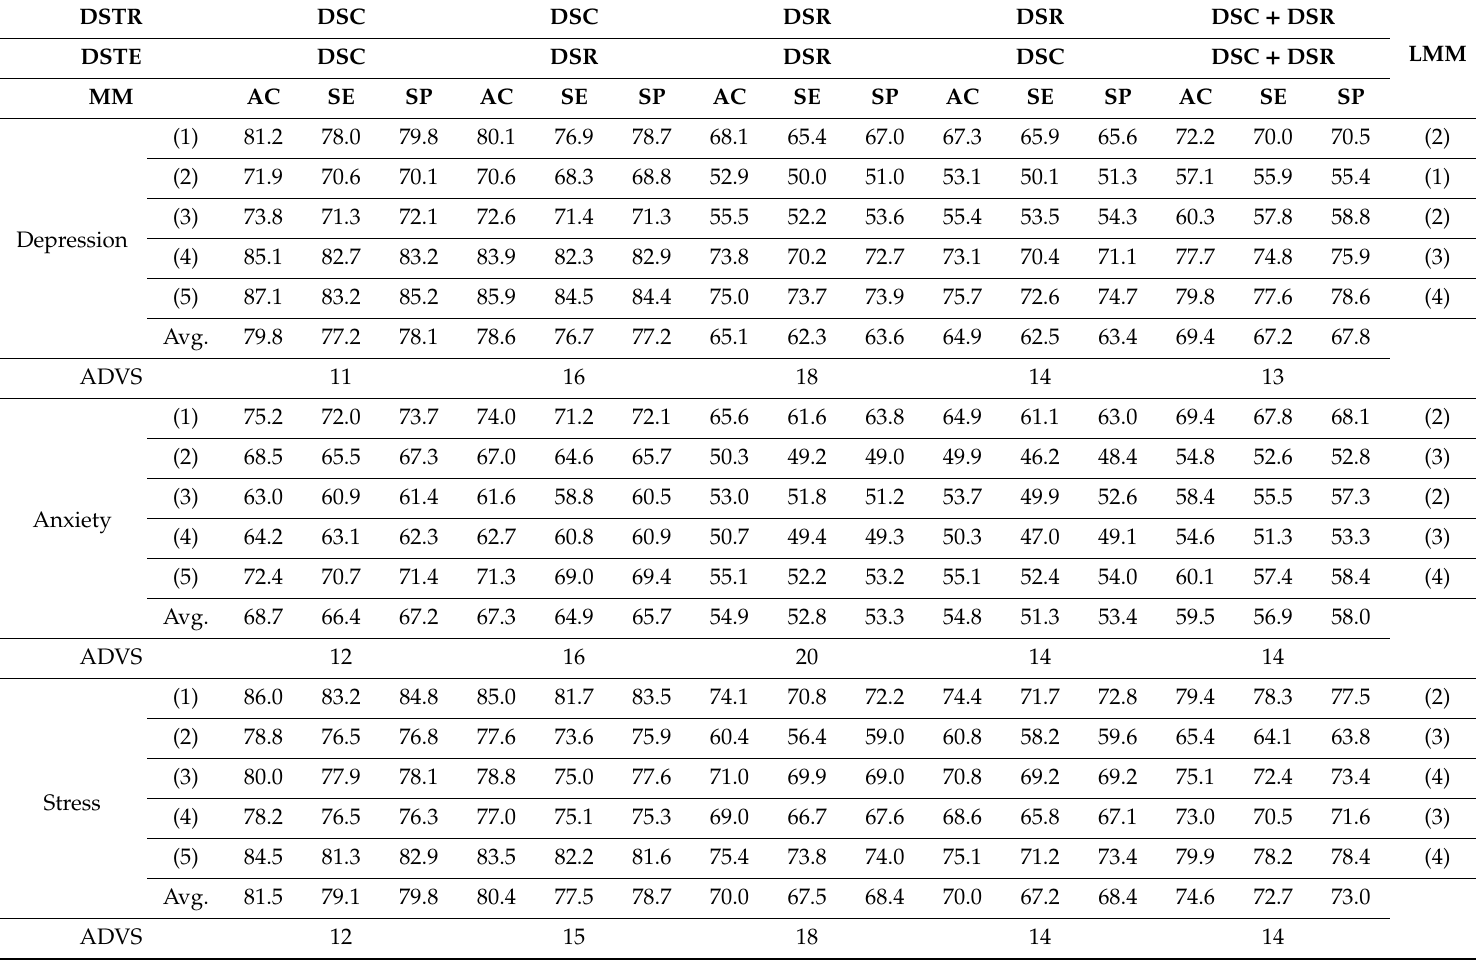
Table 2. DASS levels prediction accuracy, sensitivity, specificity, and average duration of analyzed video samples in intersubject